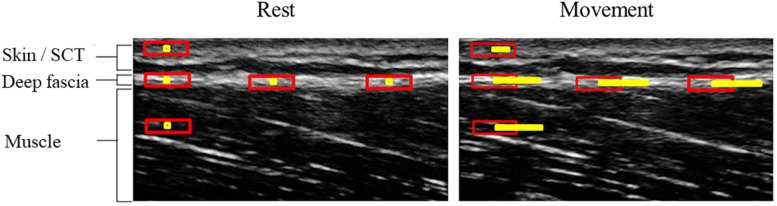
Exemplary visualization of ultrasound-based cross-correlation analysis. Equidistant ROIs (red rectangles) are selected at rest (left image). In this example, five ROIs have been positioned: three within the fascia and one in each, the subcutaneous tissue (SCT) and the muscle. Upon movement (right image), pixel displacements relative to the center of the non-moving ROIs (small yellow square inside the red rectangles in left picture) are tracked (yellow line in right picture). The end of the line indicates the maximal displacement, which is computed by the software algorithm.